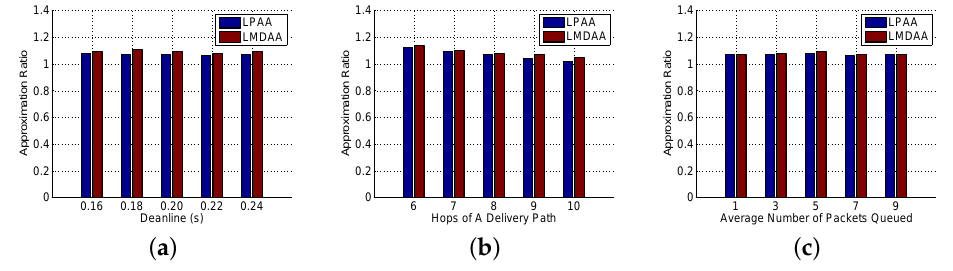
Figure 6. Computing performance of Linear Programming-based ( 1 + p min ) -Approximation Algorithm (LPAA) and Lagrange Multiplier-based Distributed Approximation Algorithm (LMDAA). ( a ) Approximation Ratio (AR) vs. deadlines; ( b ) AR vs. the number of hops; ( c ) AR vs. the average number of packets